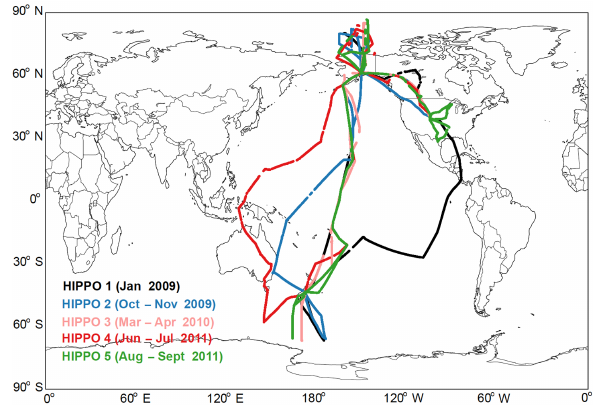
Figure 1. HIPPO aircraft flight tracks in January 2009 (black), October–November 2009 (blue), March–April 2010 (pink), June– July 2011 (red), and August–September 2011